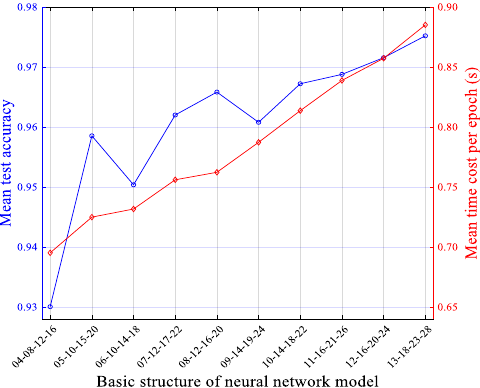
Figure 10. Training results of neural network models with different structures.